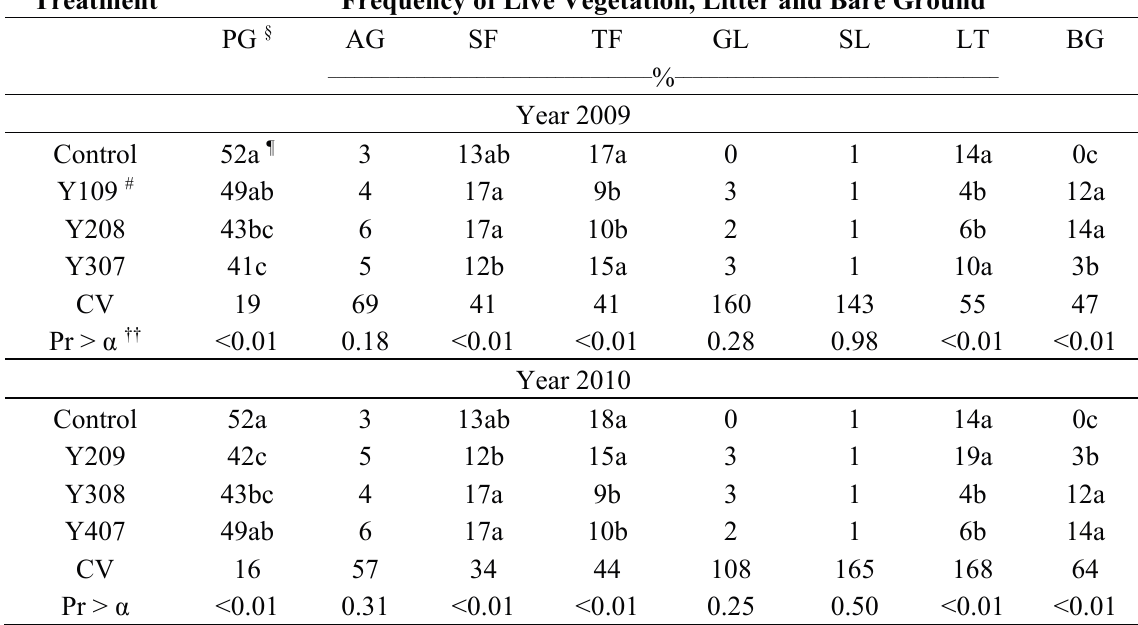
Table 5. Effects of harvest duration on the distribution of major plant types † , litter and bare ground patches in mixed native warm-season grass stands ‡ , previously harvested for one to two years (pooled means), recorded two weeks after mid-May harvests in 2009 and 2010. Treatment Frequency of Live Vegetation, Litter and Bare Ground PG